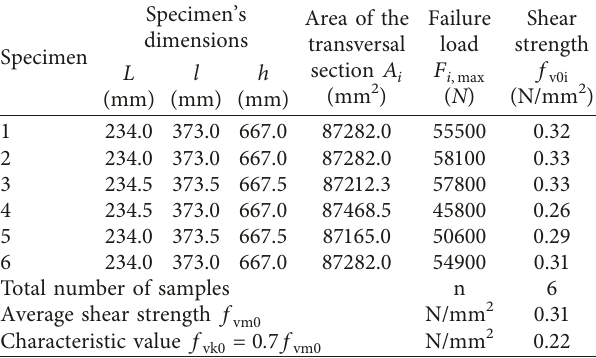
Table 4: Results of the tests on the six specimens.